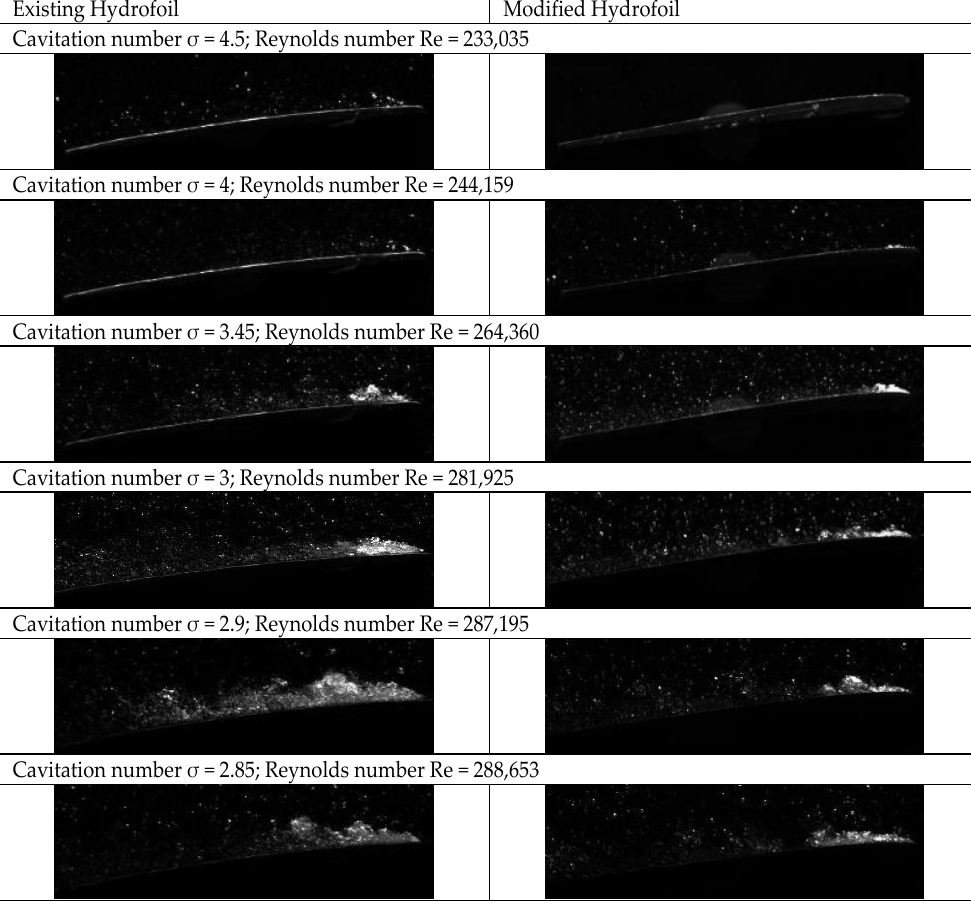
Figure 11. Visualization results of cavitation structures at p abs = 0.45 bar.